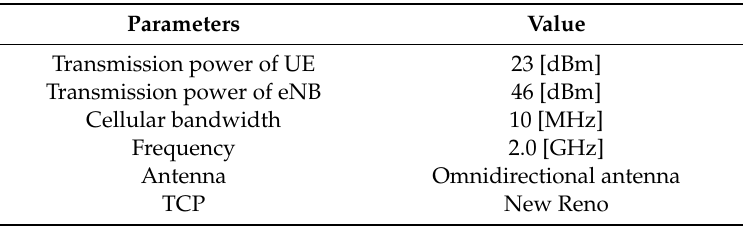
Table 2. Network environment